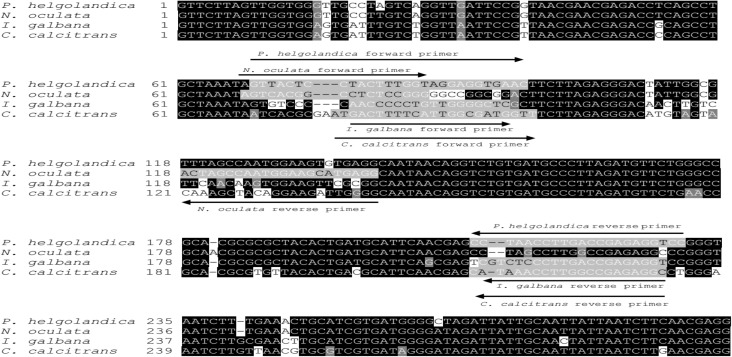
Sequence of 18S rDNA of Chaetoceros calcitran, Isochrysis galbana, Platymonas helgolandica and Nannochloropsis oculata.Primers used for qPCR is underlined.